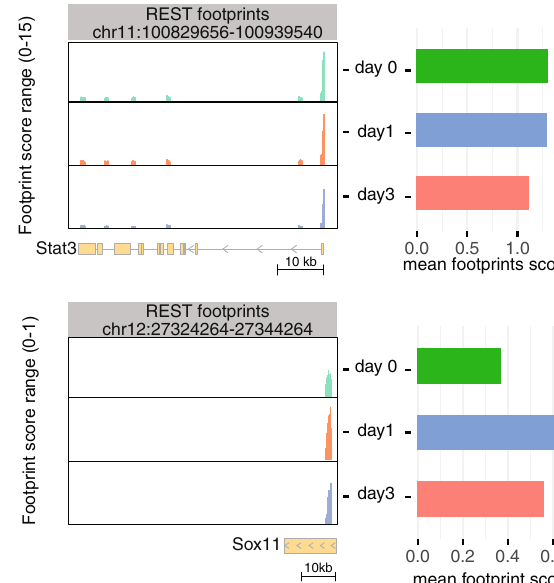
where this TF binds. b Promoter (±2kb of a gene ’ s transcription start site) acces- sibilityandexpressionchangesof801REST-targetedgenesatindicatedtimepoints following CNSinjury. Normalized ATAC-seqand RNA-seq counts scaled by row are displayedin the heatmaps. c Genome-browser views ofREST footprinted sites and barplots of mean REST footprint scores within indicated genomic distances of the regenerative TFs ( Atf3, Stat3, Smad1, Sox11 ). The footprint scores are calculated with TOBIAS as described in a , indicating REST binding activities at these genes. The genomic distance covers the entire gene from 2kb upstream of a gene ’ s transcription start site, to 1kb downstream of the end of the gene. The coding exons of a gene are displayed as yellow boxes connected by horizontal lines representing introns. Arrowheads on the connecting intron lines or the coding exons indicate the direction of